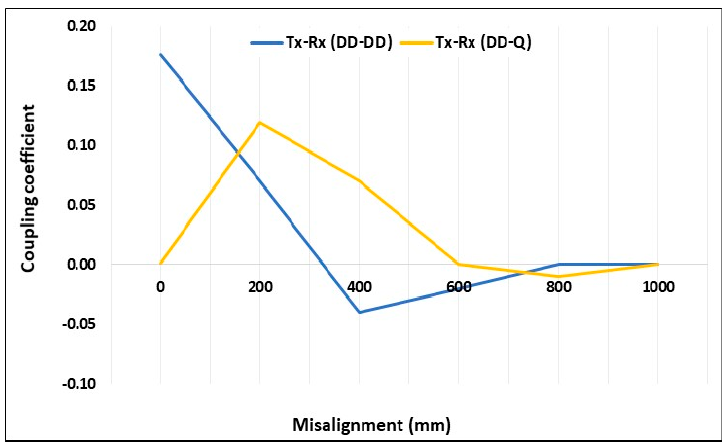
Figure 27. Variation of the coupling coefficient (k) as a function of the misalignment along the y-axis for the DD–DDQ configuration.